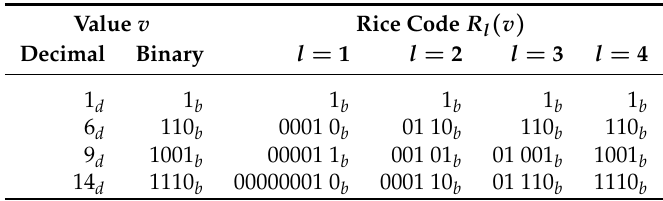
Table 2. Some examples of Rice